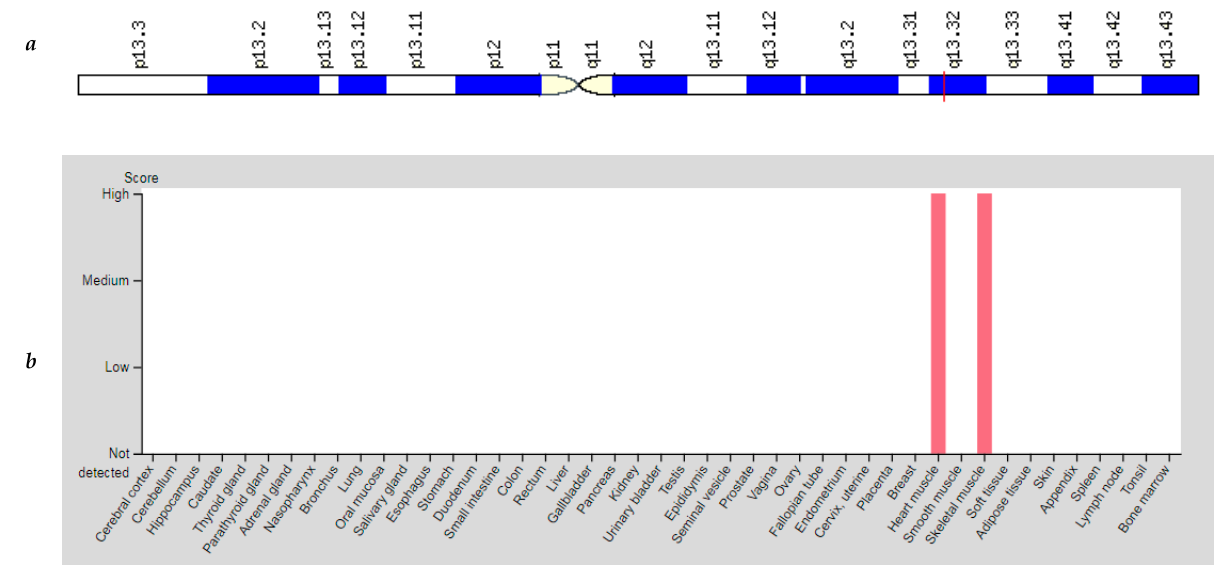
Figure 6. Location of the CKM gene ( a ) and tissue expression of the creatine kinase, muscle ( b ). The CKM is expressed at a high level in tissues with a high demand for energy, for example, in skeletal muscle and heart muscle (Figure 6b), which makes it possible to quickly restore ATP stores, which are the main source of energy in biochemical processes